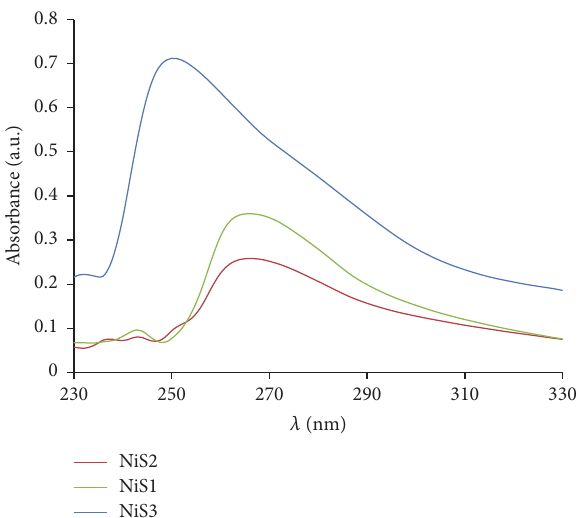
Figure 4: PL spectra of HDA-capped NiS nanoparticles.